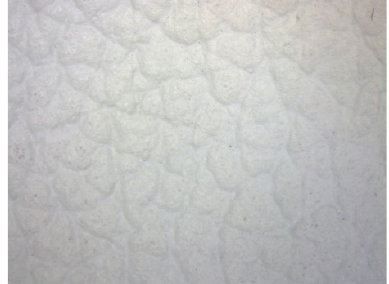
Figure 8. Tanned leather from the sports footwear.